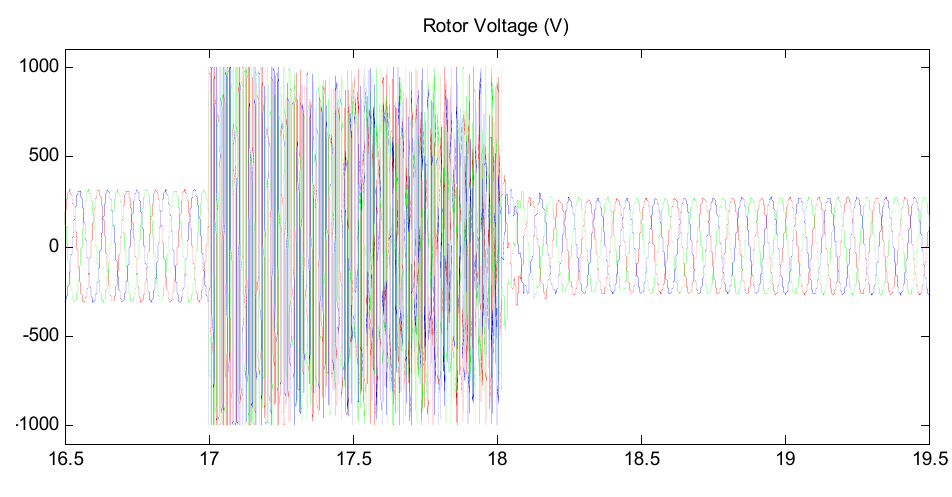
Figure 10. Rotor Voltage, (V) vs. time, (s).